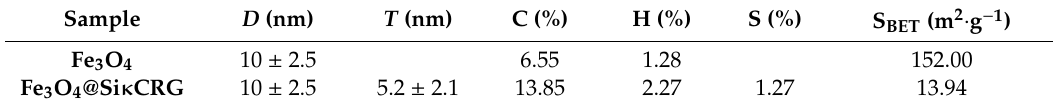
Table 1. Elemental analysis and textural properties of citrate-capped Fe 3 O 4 and Fe 3 O 4 @Si κ CRG